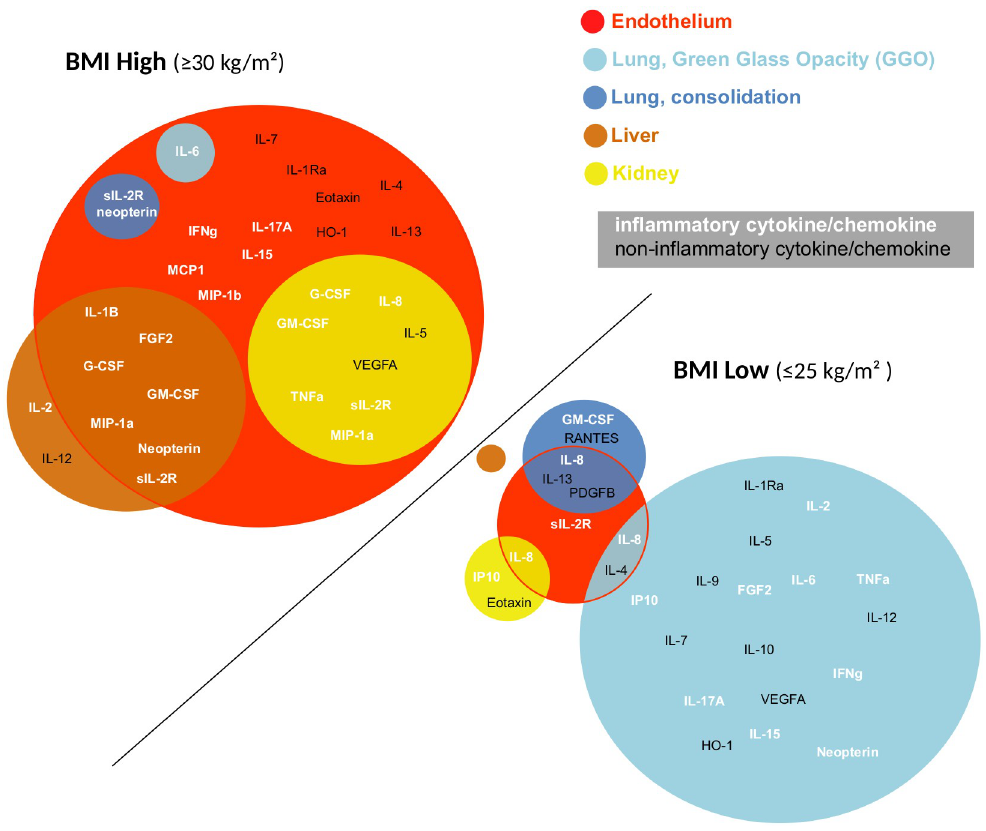
Fig 6. Diagram representing the cytokines correlated with multiorgan damage of endothelial vessels, lung (consolidation and GGO), liver, and kidney in patients with obesity (BMI � 30) as compared to normal-weight patients (BMI � 25). Inflammatory cytokines are illustrated in white and noninflammatory in black.